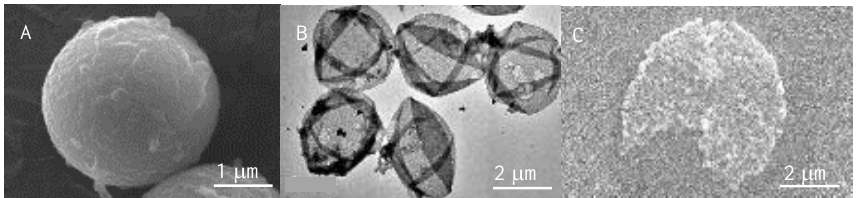
Figure 4. Fabricated microcapsules. ( A ) SEM image of the MF particle core. ( B ) TEM image of the inner shell after the removal of the MF particle core. ( C ) SEM image of particle after UV irradiation.